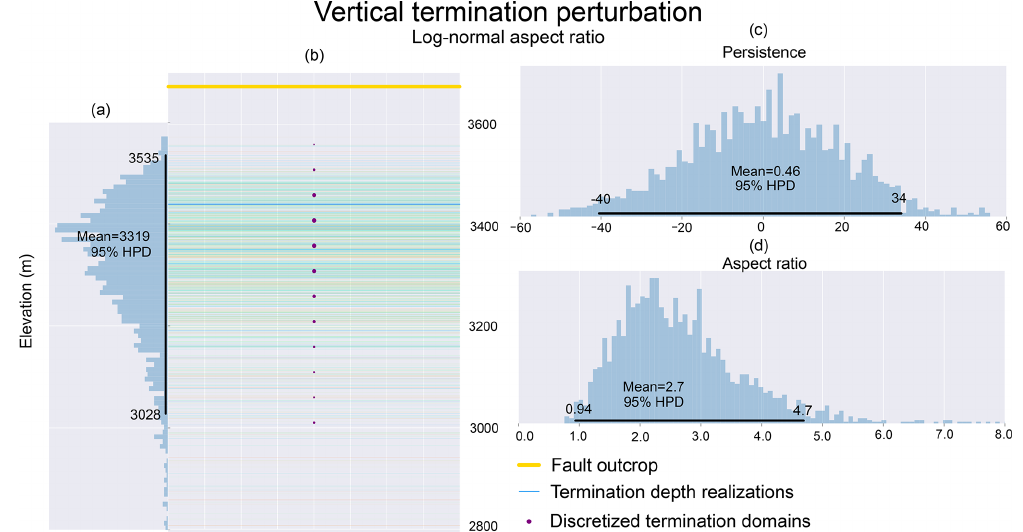
Figure 8. Visualization of Monte Carlo samples and associated geologic input realizations from perturbation of the fault zone vertical termination depth, reparameterized using a log-normal distribution of fault aspect ratio. The 95% highest predictive density is overlain on the histograms of the Monte Carlo samples.